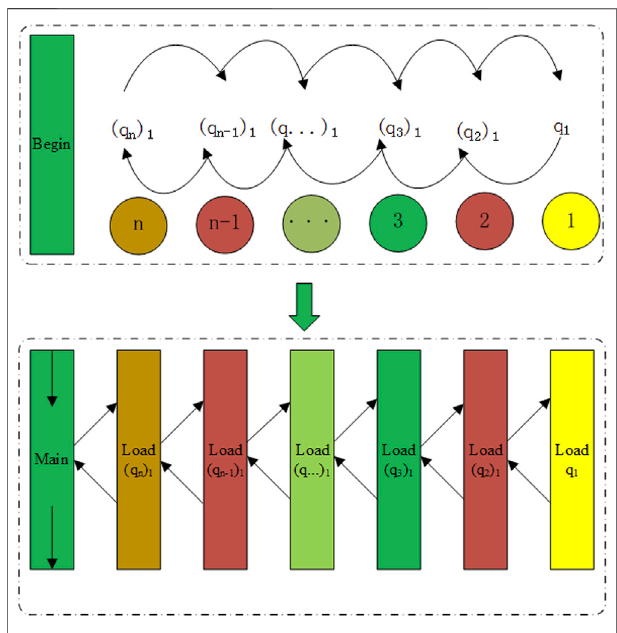
FIGURE 6 | Load calculation process.